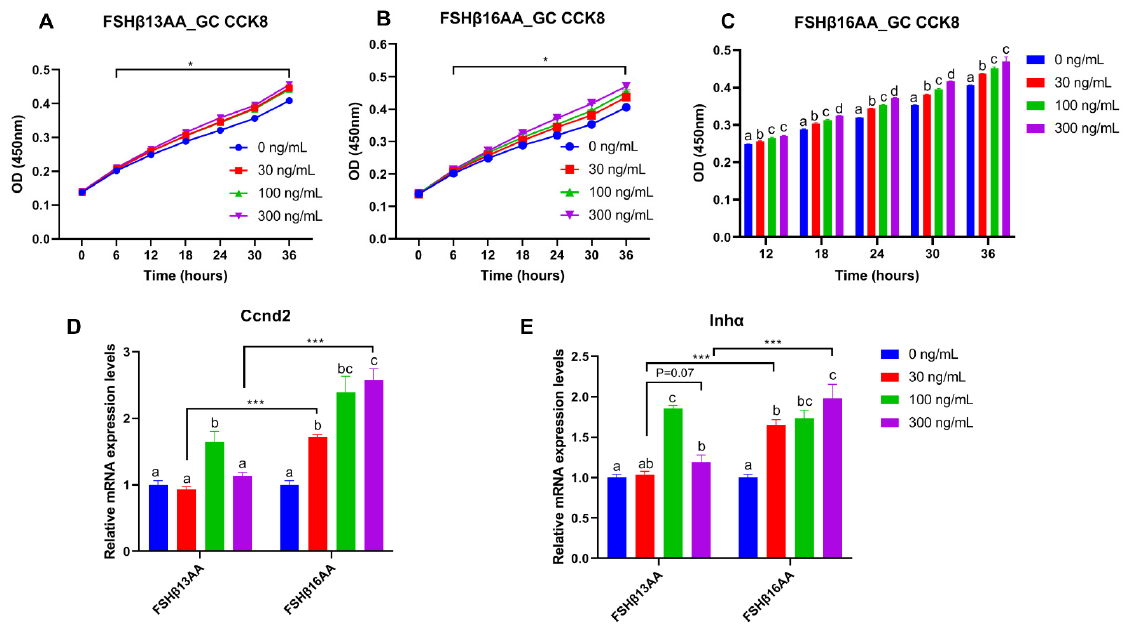
doses (30 and 300 ng/mL; Figure 7D,E).